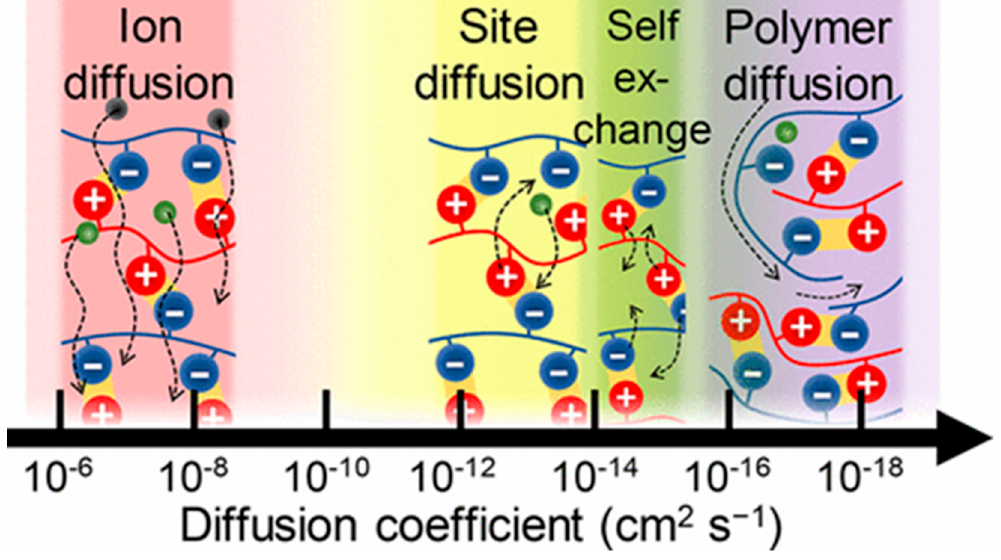
Figure 3. Dynamics within PEMs. Figure taken from reference [97]. Copyright © 2020 American Chemical Society.